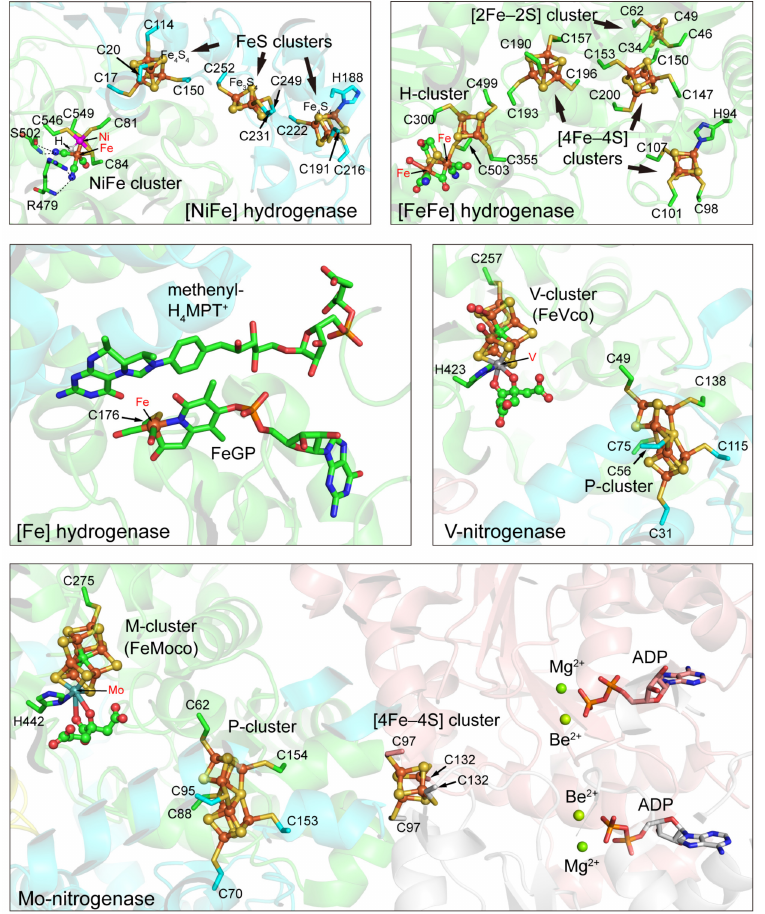
Figure 2. Cofactors and metal clusters in the structures of various hydrogenases and nitrogenases. The coordinating residues in proteins are shown as sticks. The PDB accession numbers, element color codes, and references of the structures are the same as those in Figure